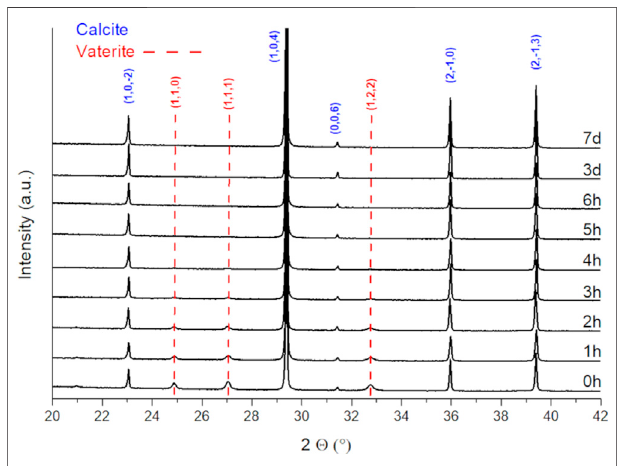
FIGURE 1 | XRD patterns of precipitated and dried CaCO 3 prepared applying different aging times.